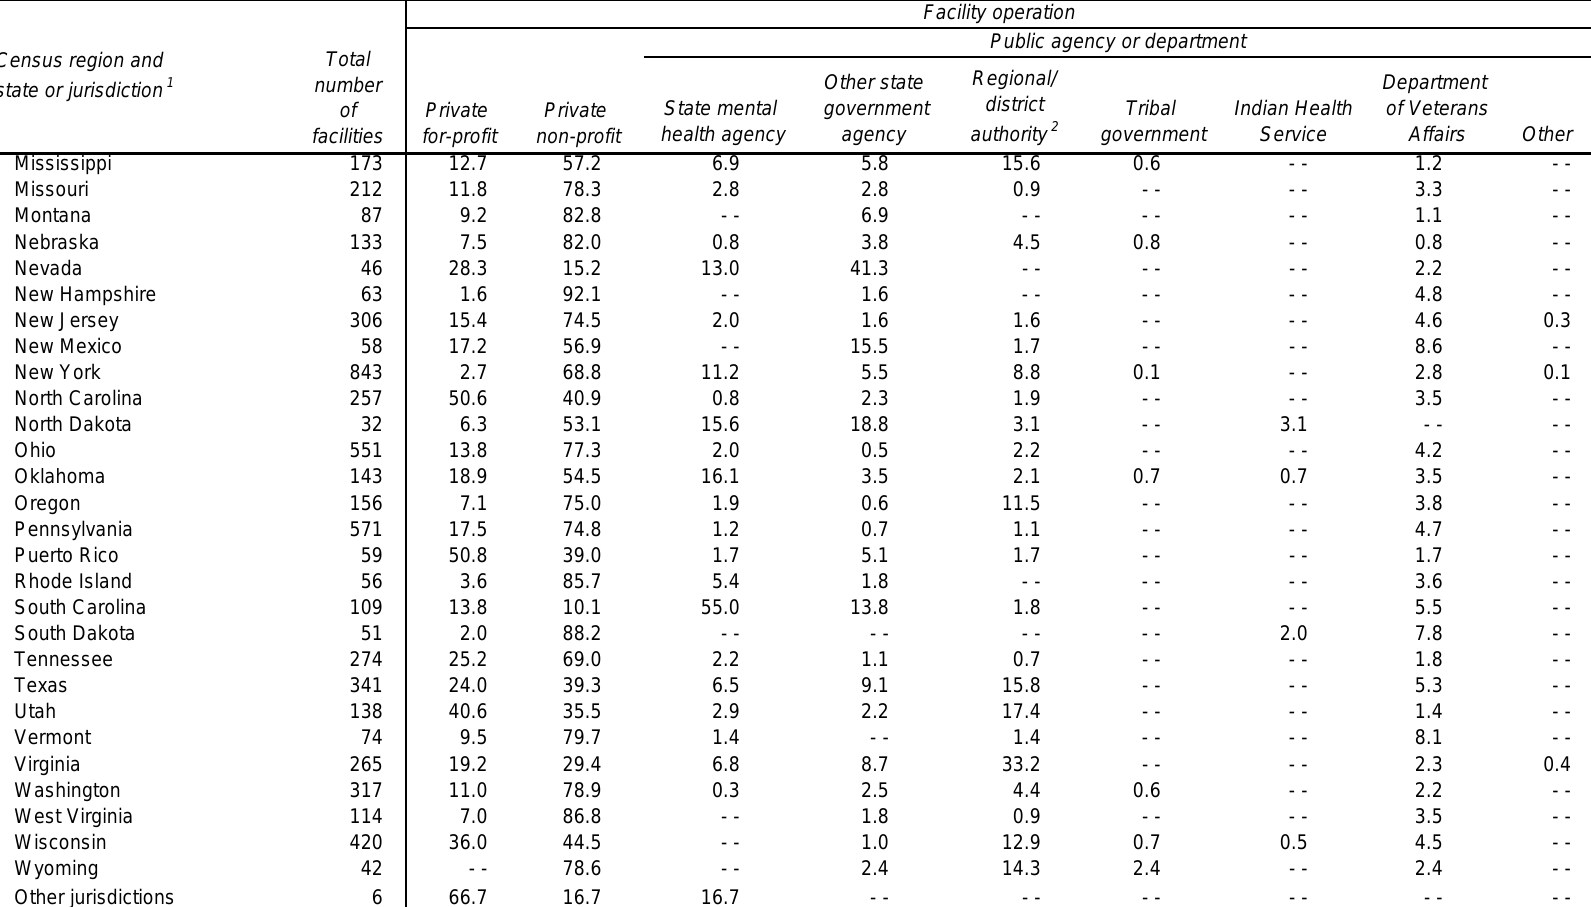
Table 3.2b. Mental health treatment facilities, by facility operation, Census region, and state or jurisdiction: Percent, 2017